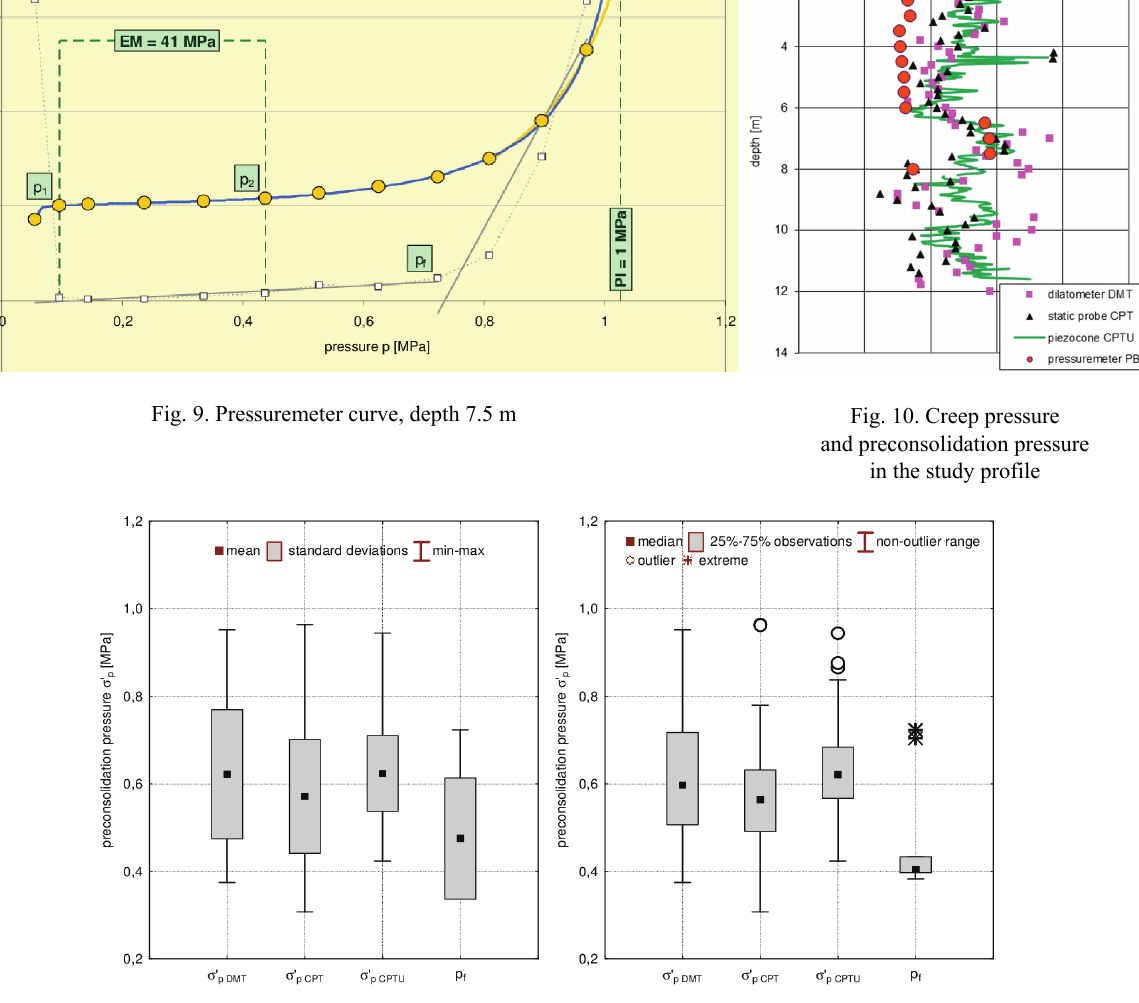
Fig. 11. Boxplots of preconsolidation pressure and creep